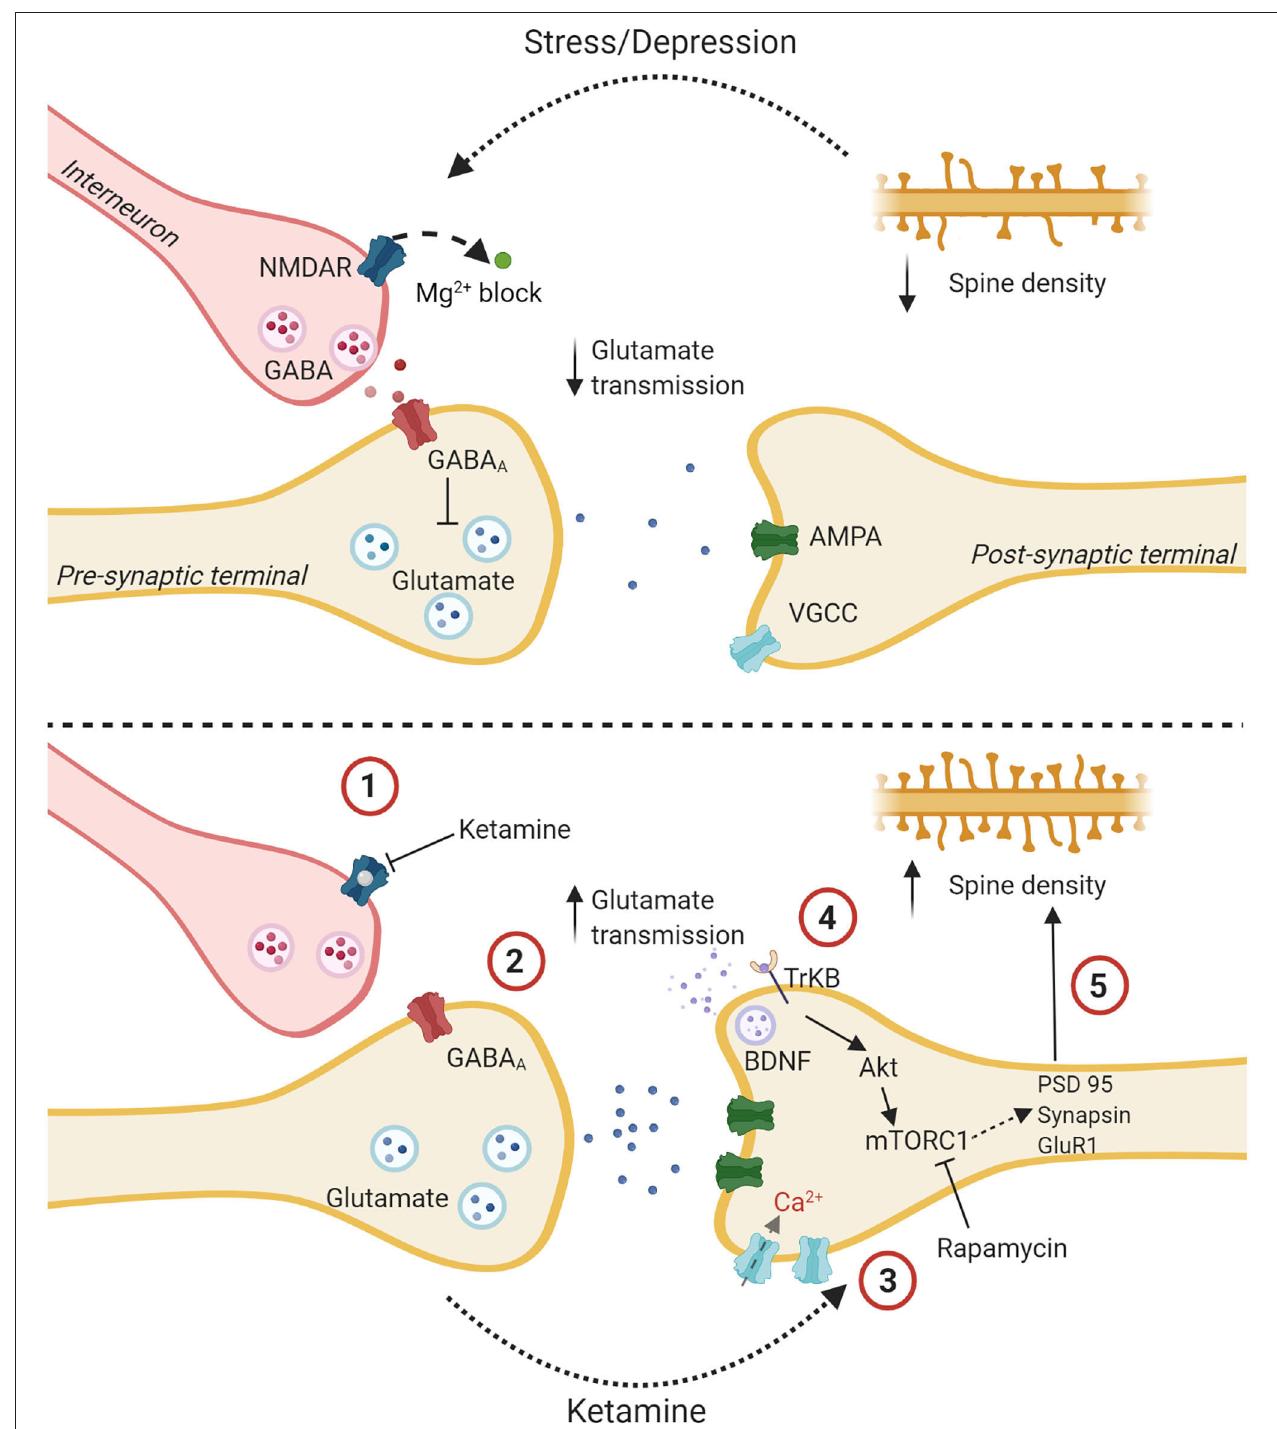
FIGURE 3 | The glutamate burst hypothesis: a proposed mechanism of action for ketamine. The upper panel shows a glutamatergic synapse tonically inhibited by a GABAergic interneuron with decreased spine density and altered glutamatergic transmission due to stress and depression. The lower panel delineates putative steps for ketamine’s antidepressant effect. (1) Ketamine binds to an NMDA receptor on a GABAergic interneuron. (2) This reduces the tonic inhibition of a glutamatergic presynaptic terminal which causes the release of bursts of glutamate. (3) Increased signal transmission leads to upregulation of AMPA receptors, increased depolarization, and influx of Ca 2 + through Voltage gated calcium channels. (4) Higher intracellular Ca 2 + leads to the release of BDNF which binds to the TrKB receptor. The Akt pathway is activated followed by the mTOR pathway. (5) This leads to the synthesis of synaptic proteins and increased spine density. Created with